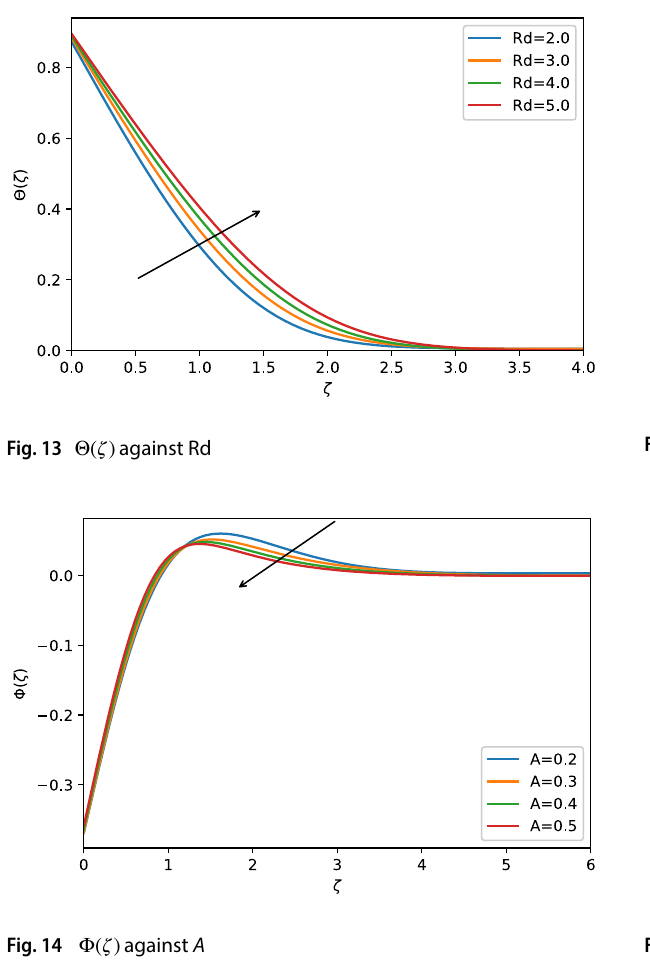
Fig. 16 Φ( 𝜁 ) against Nb